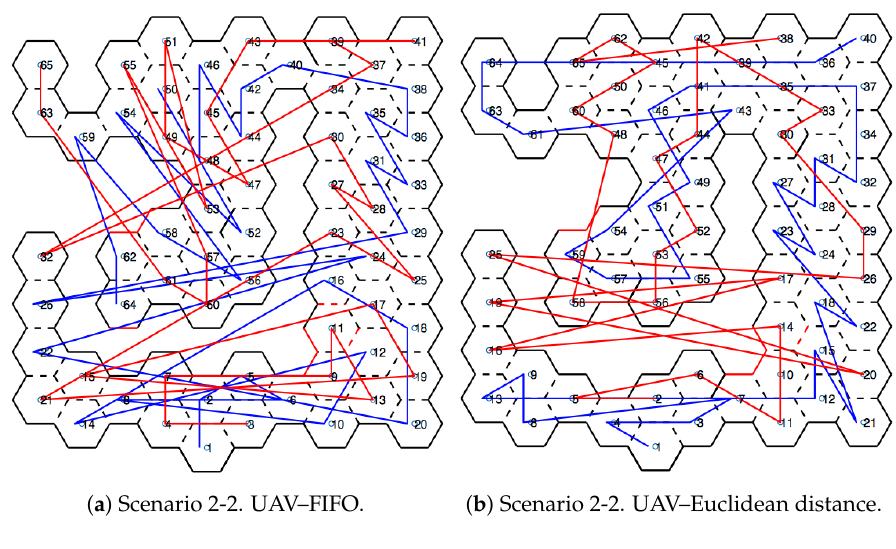
Figure 13. Exploration order—Scenario 1.